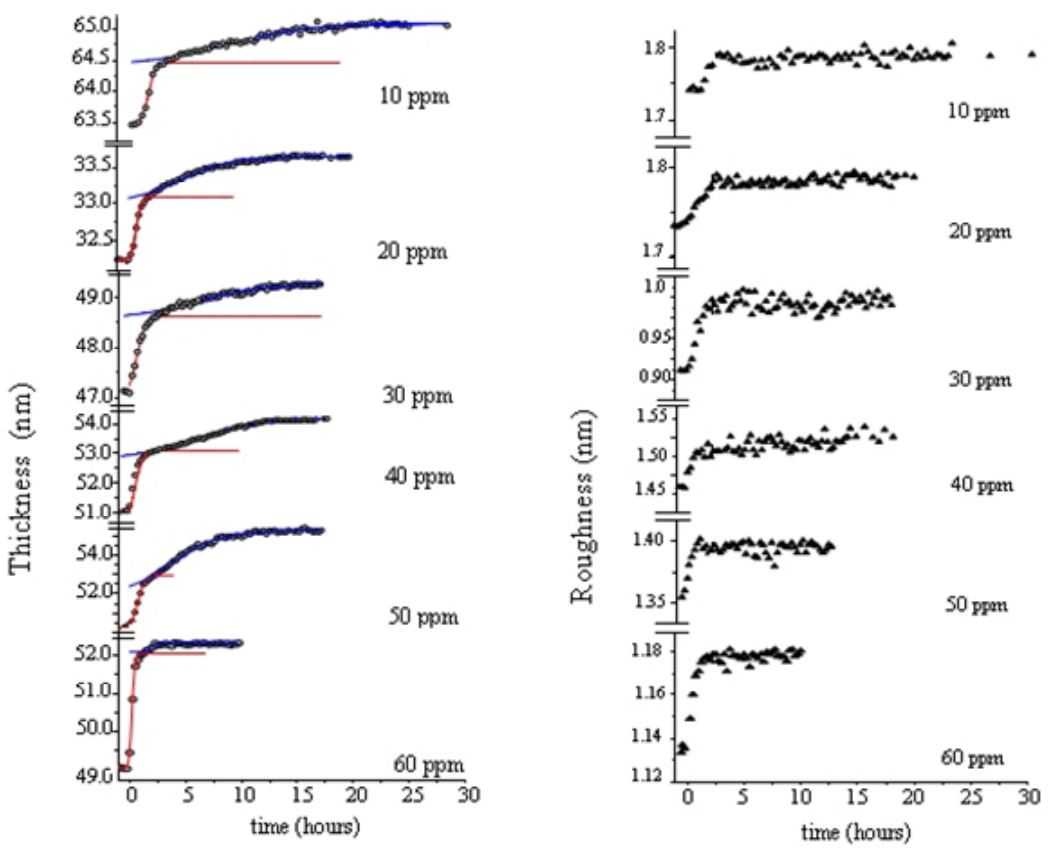
Figure 11. Time evolution of the morphological parameter d (thickness) and σ (roughness) for different NO concentrations [38] of (PcRu) 2 different initial